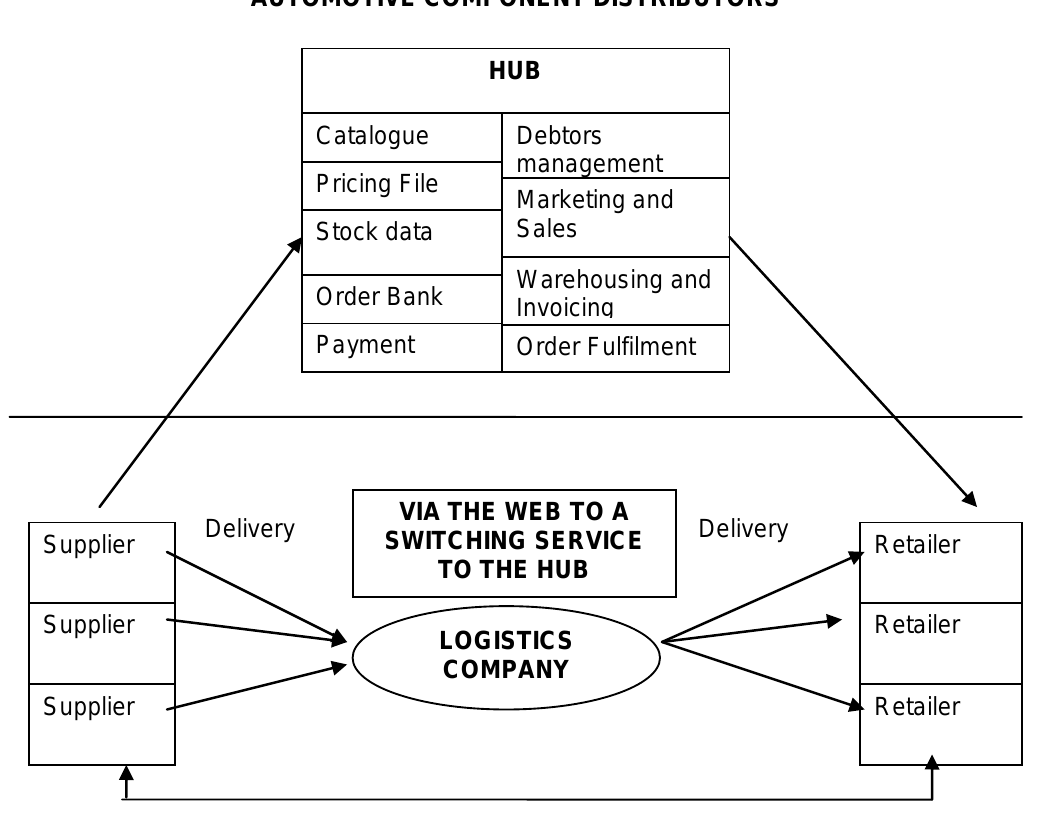
Figure 3: Proposed centralised distribution model “ AUTOMOTIVE COMPONENT DISTRIBUTORS